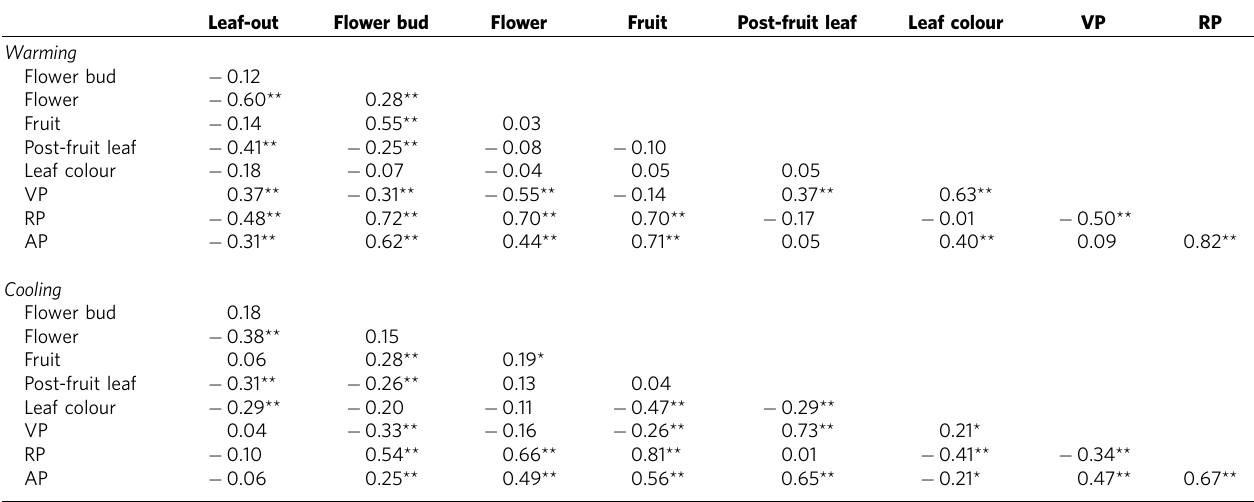
Table 4 | Correlations among temperature sensitivities of phenological duration. Leaf-out Flower bud Flower Fruit Post-fruit leaf Leaf colour VP RP Warming Flower bud